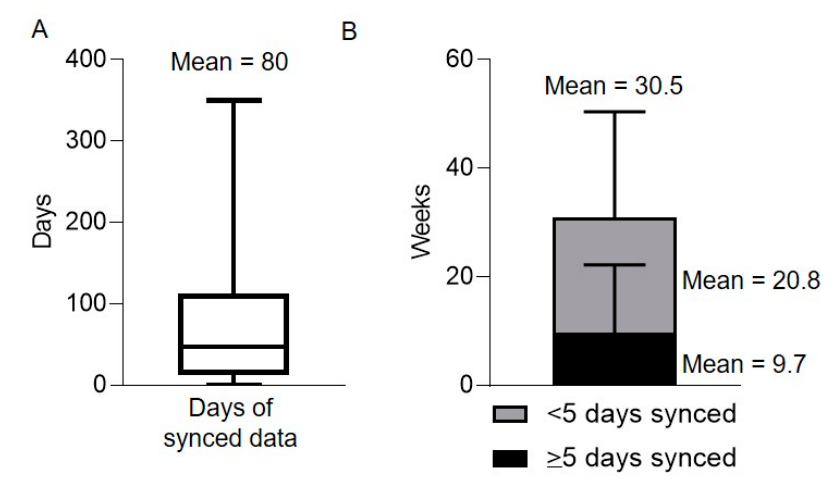
Figure 2. Fitbit data quantity and quality varied between patients. ( A ) Total number of days of Fitbit data synced ( n = 80 patients); ( B ) Total number of weeks on study separated by the number of weeks with ≥ 5 days of synced data (black) and the number of weeks with < 5 days of synced data (gray). Bars show the mean ± standard deviation, n = 80